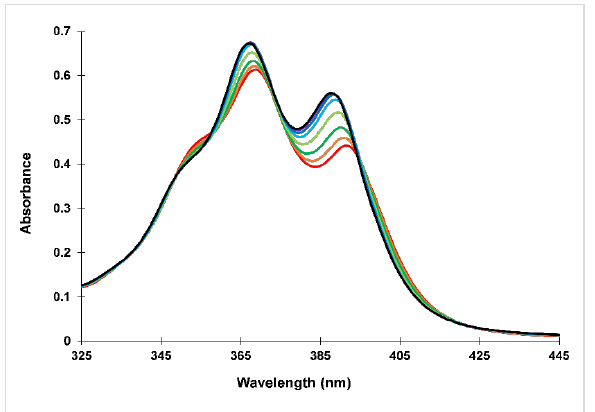
Figure 5: Temperature-dependent UV–vis absorption spectrum of 1 * 2 . Conditions: see Table 1.